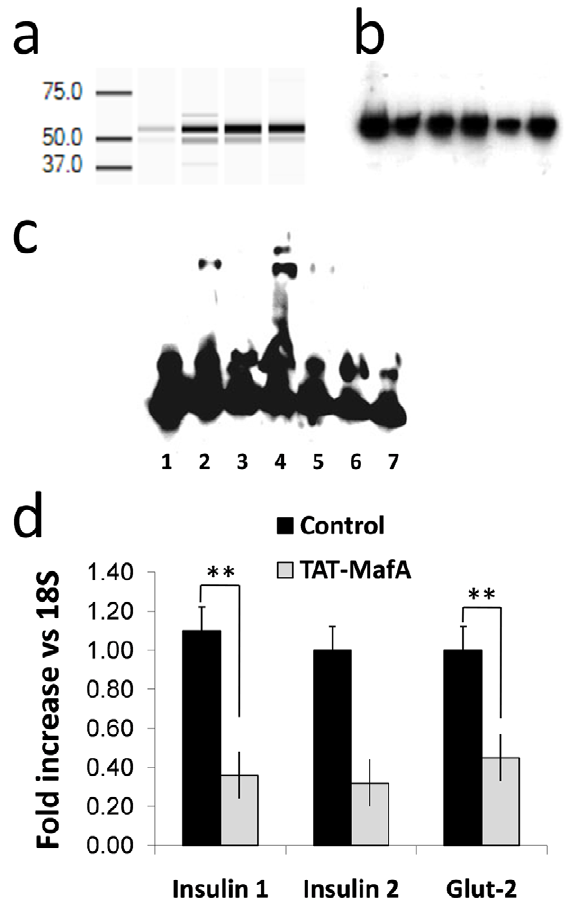
Figure 2. In vitro activity of TAT-MafA. (A) Experion TM virtual run of the last the purest eluate of TAT-MafA (far right), preceded by the three previous ones. (B) Western blot (MafA antibody) was used to confirm the identity of the purified protein. (C) Electrophoretic Mobility Shift Assay (EMSA). All samples include biotin-labeled DNA. 1. Labeled DNA alone (baseline control); 2. TAT-MafA (no competitor); 3. TAT- MafA + unlabeled DNA competitor (control); 4. Kinase treated TAT-MafA; 5. Kinase treated TAT-MafA + unlabeled DNA competitor (control); 6. Kinase alone (control); 7. Kinase + unlabeled DNA competitor (control) (D) qRT-PCR to measure relative expression of key pancreatic genes (insulin 1, insulin 2 and Glut-2) in e14.5 buds treated with TAT-MafA or vehicle. Black columns: control (vehicle); grey columns: TAT-MafA treatment. Bars: standard error.